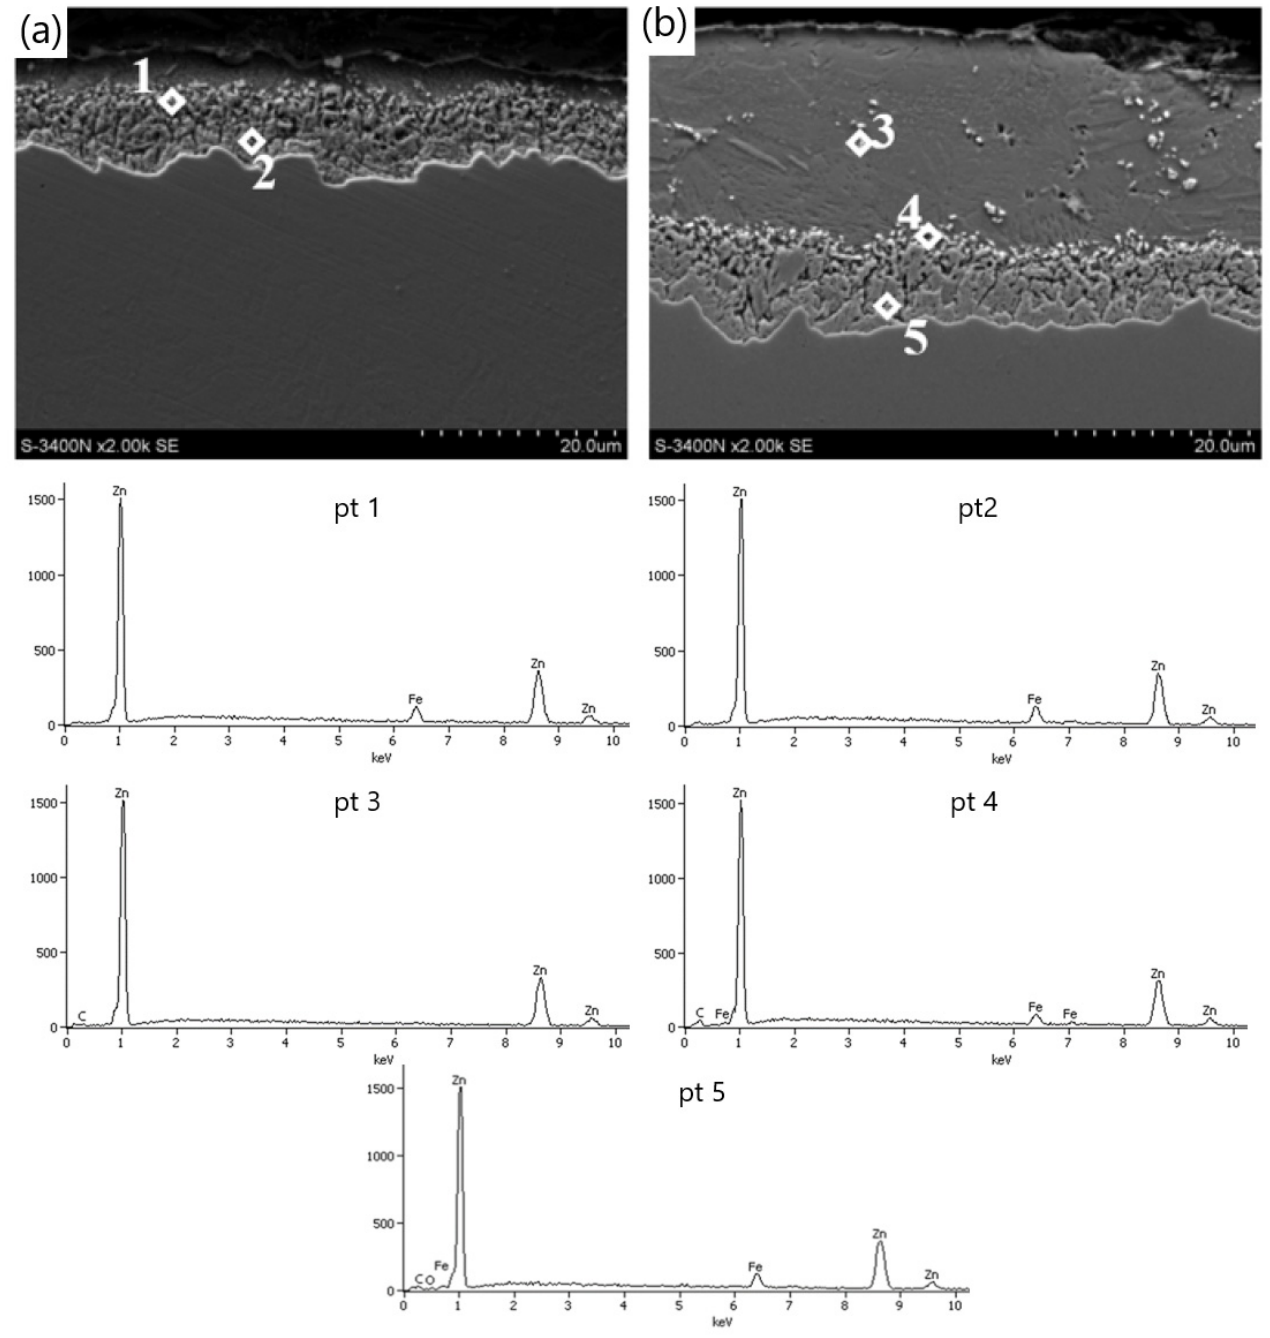
Figure 4. The (SEM) coating microstructure and EDS X-ray spectral analysis in the micro-areas of the coating on the cross-section of the wire from variants ( a ) K20 and ( b ) H20.